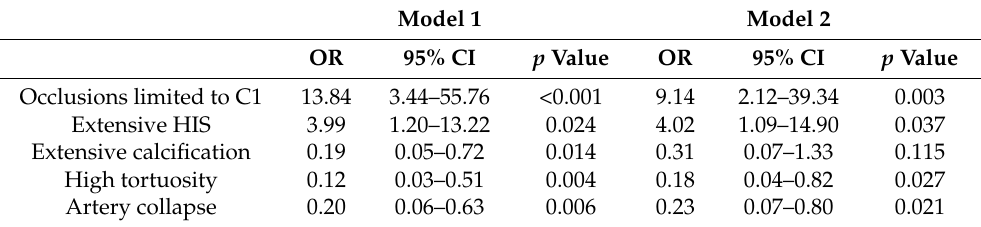
Model 1: adjusted for clinical characteristics, including age, male sex, smoking and symptom status. Model 2: adjusted for clinical characteristics and DSA characteristics, including distal ICA reconstitution with contralateral injection and distal ICA reconstitution at or before clinoid segment. OR = odds ratio; CI = confidence interval.